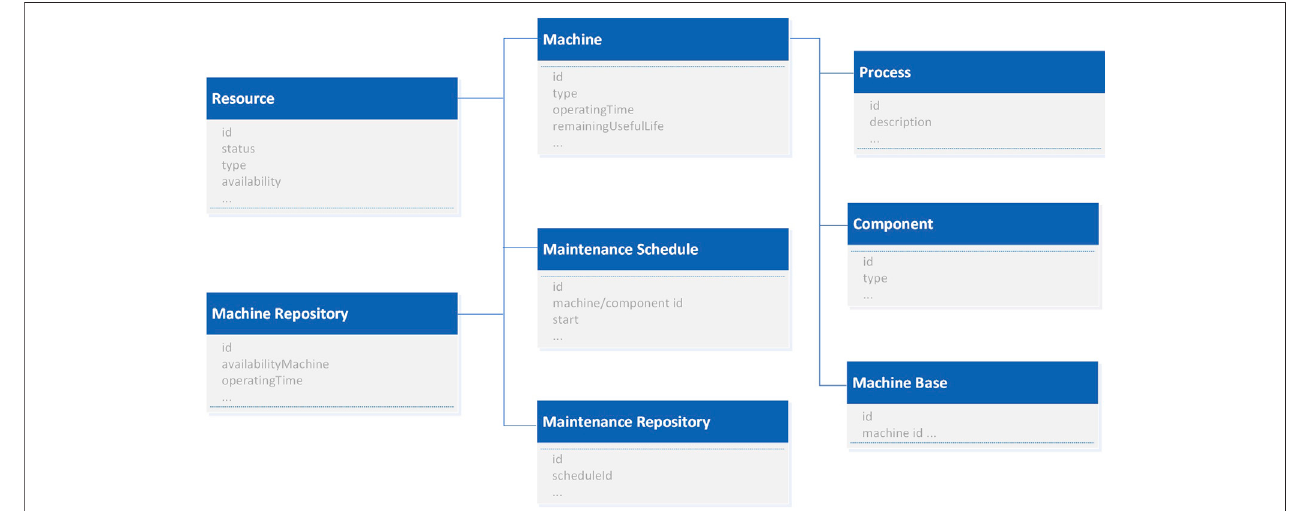
FIGURE 2 | Sample data model for predictive maintenance for Industry 4.0.